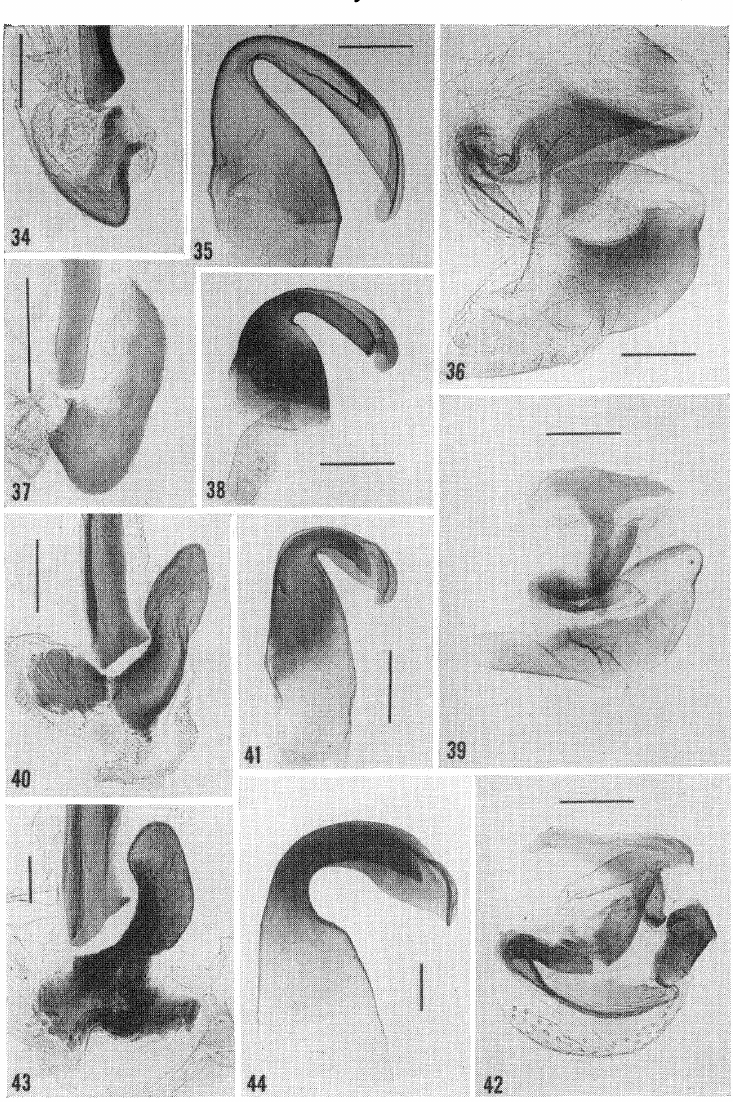
Figs. 34-44. 34-36. (106 ANSP). Zetobora areola. (from adult shown in Fig. 3; Fig. 34 is a ventral view). 37-39. (113 ANSP). Phortioecoides guarani. (from adult shown in Fig. 5). 40-42. (102 ANSP). Zetoborella gemralcula. (from adult shown in Fig. 11). 43-44. (97 ANSP). ,Tchizo- lilia fissicollis. (from adult shown in Fig. 9). (scale 0.2